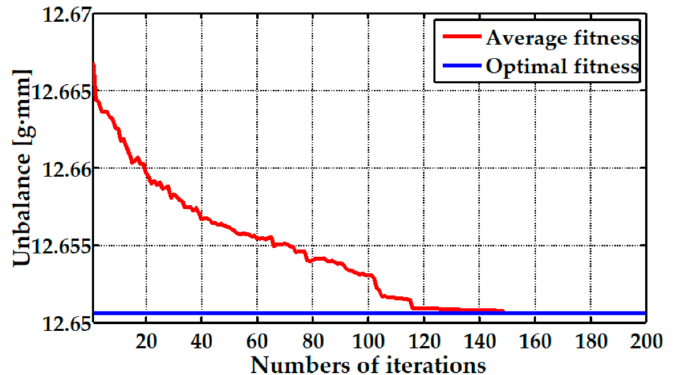
Figure 8. The convergence progress of the single-objective optimization for the unbalance based GA.